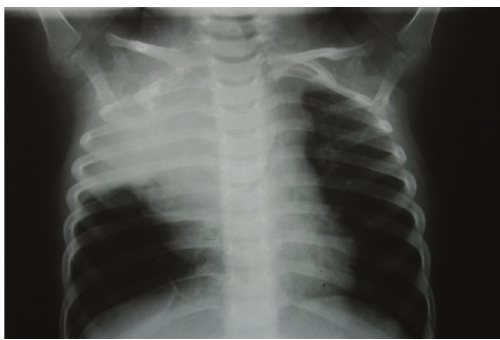
Figure 3: Immunohistochemistry from the lesion showing CK and CD 99 positive in Case 1 ( × 400 magnification).